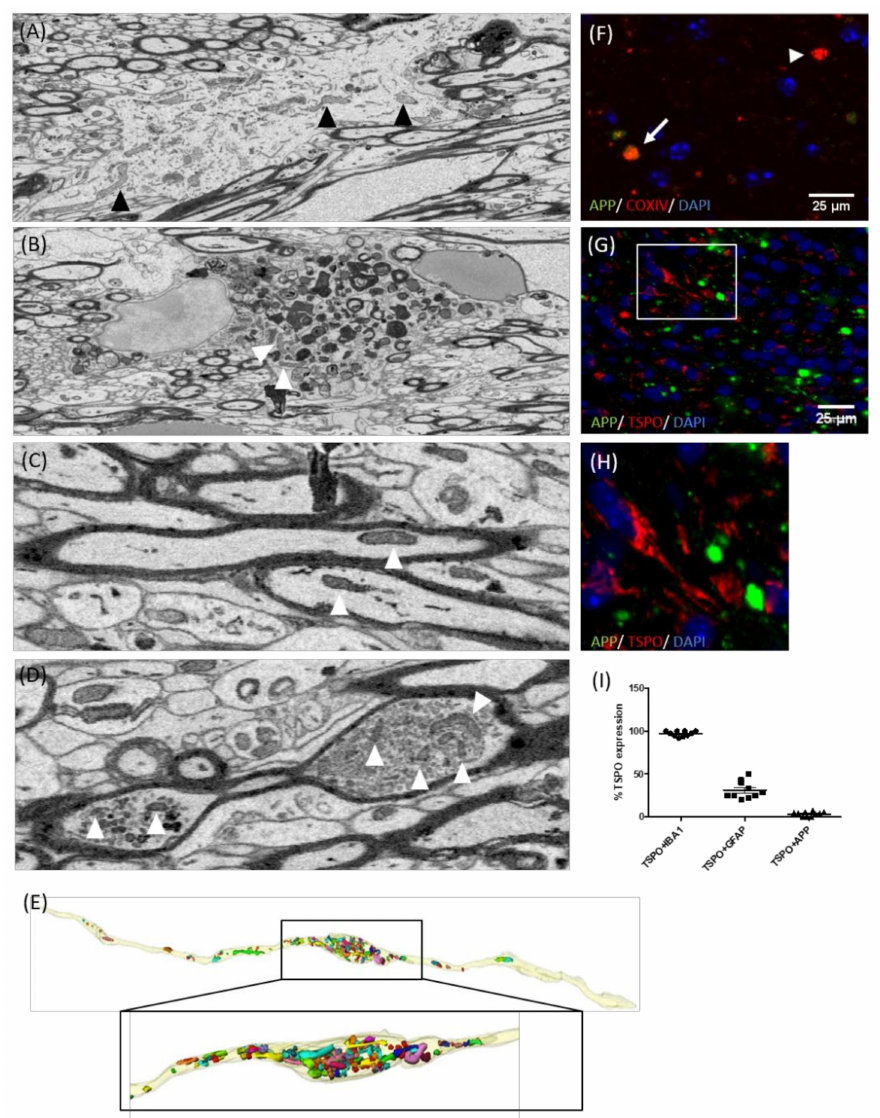
Figure 7. Accumulation of mitochondria in the damaged axons. The representative electron microscopic images demonstrating mitochondria (arrowheads) in the astrocytes ( A ), phagocytosing microglia ( B ), myelinated axons ( C ), or axonal swellings ( D ). The mice were intoxicated with cuprizone for three weeks ( n = 4). The arrowheads highlight mitochondria. ( E ) 3D reconstruction of an axonal swelling. The mitochondria are highlighted by different colors. ( F ) The representative image of APP (green) and COXIV (red) immunofluorescence double stains in the 5-week cuprizone-intoxicated mice. The arrowhead highlights a COXIV + single-positive, and the arrow highlights a COXIV + /APP + double-positive spheroid. ( G ) The representative image of APP (green) and TSPO (red) immunofluorescence double stains in the 5-week cuprizone-intoxicated mice. The white box highlights a region which is shown in ( H ), at higher magnification. ( I ) The percentage of microglia (IBA1 + ), astrocytes (GFAP + ) or axonal spheroids (APP + ) co-expressing